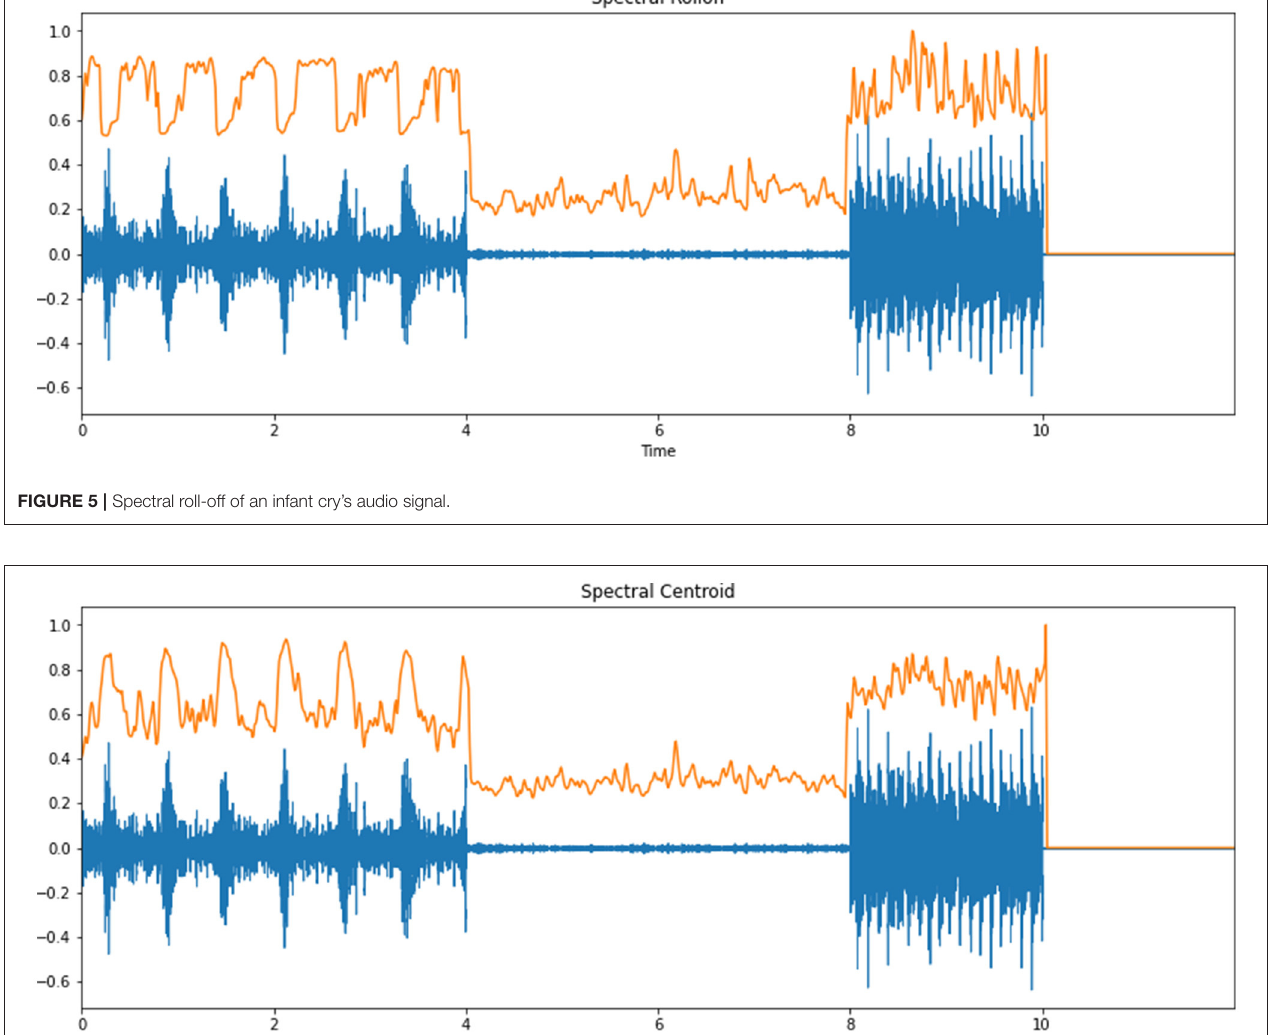
FIGURE 6 | Spectral centroid of an infant cry’s audio